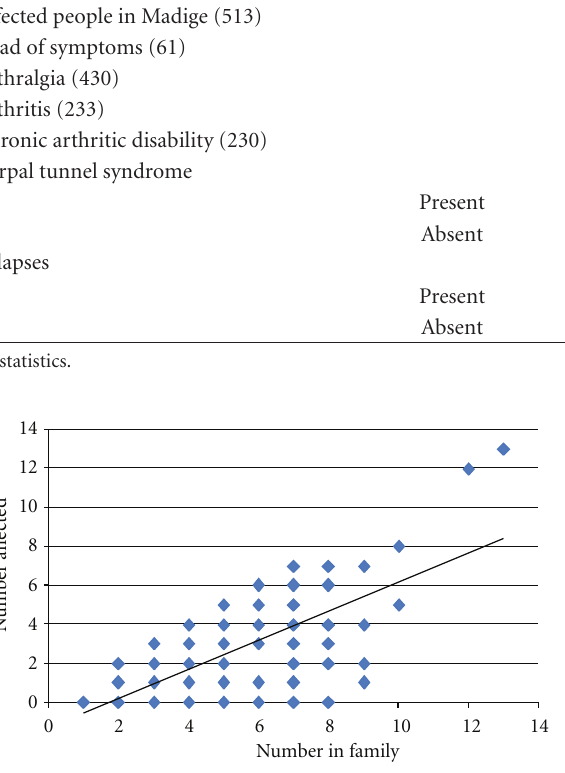
Figure 2: Relationship between numbers of a ff ected per family and number of individuals per family.